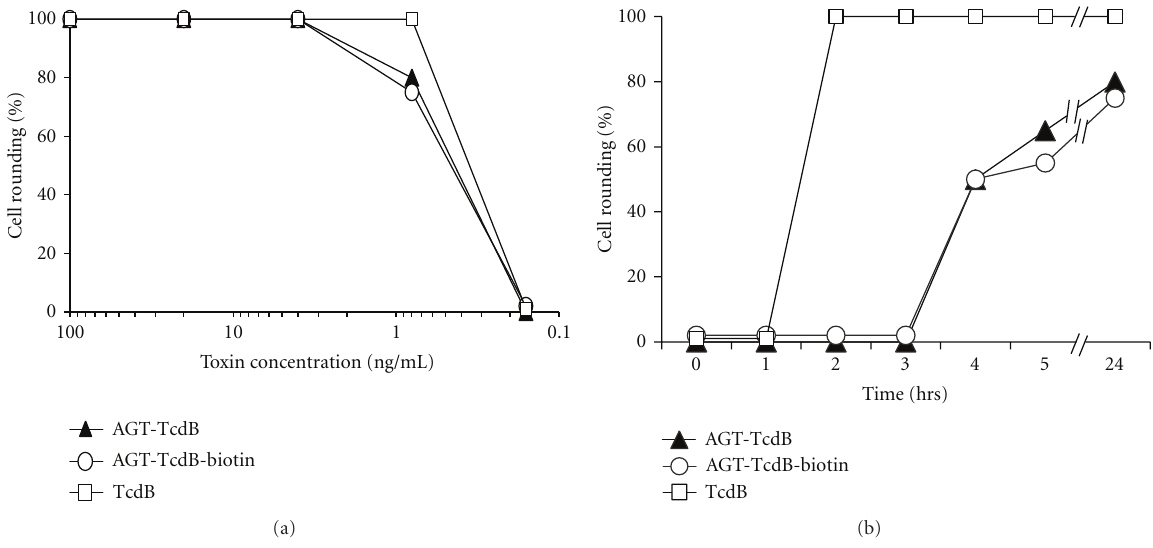
Figure 3: TcdB with an N-terminal AGT-tag retains cytotoxic potency. (a) AGT-TcdB potency as a function of protein concentration. Vero cells were treated with serial dilutions of TcdB and AGT-TcdB ± autobiotinylation. The dilution series started at 100 ng/mL and continued with fivefold serial dilutions. The % cell rounding was assessed after 24 hr for each concentration tested. (b) AGT-TcdB potency as a function of time after exposure. Vero cells were exposed to 0.8 ng/mL of TcdB or AGT-TcdB, and the % cell rounding was assessed hourly for five hours and then after 24 hr. The data shown in both (a) and (b) are representative of 3 independent